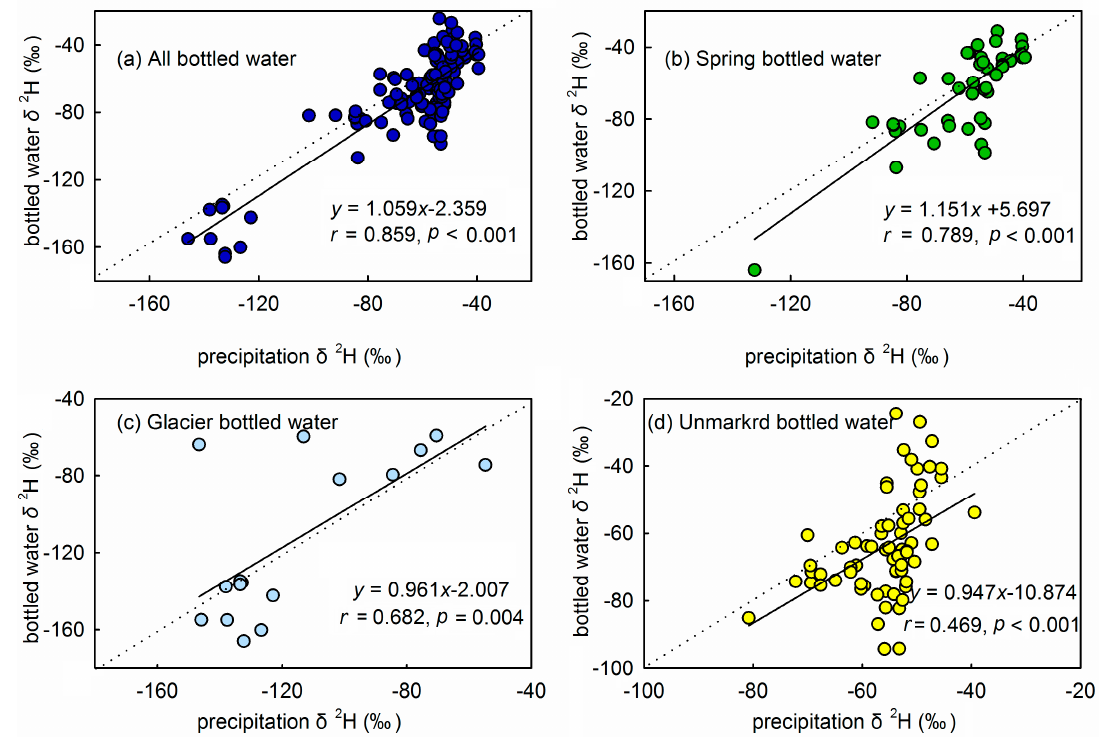
Figure 5. Correlations between δ 2 H in precipitation [25] and ( a ) all bottled water samples, ( b ) spring-sourced bottled water samples, ( c ) glacier-sourced bottled water samples and ( d ) source unmarked bottled water. The solid line is the linear least squares fitting. The dotted line is the line of slope equality (y = x).